Question: Write a descriptive caption for this figure.
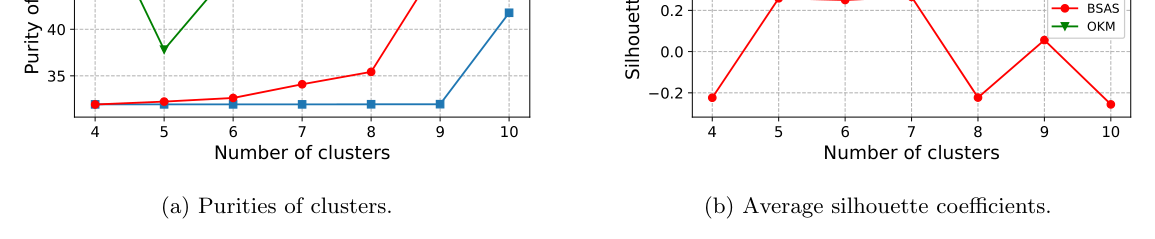
Answer: The relation between the number of clusters and the purity of clusters (a), respectively, the average silhouette coefficient (b). The online clustering algorithms were directly applied to the unlabeled dataset D and the streaming data S.